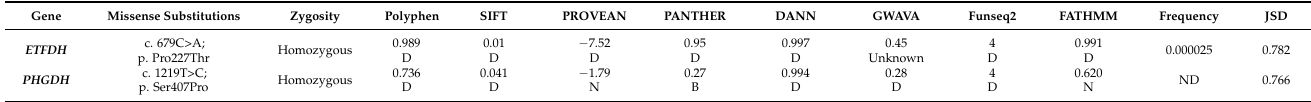
Table 3. In silico prediction and analysis of ETFDH and PHGDH variants detected in the patient. Gene